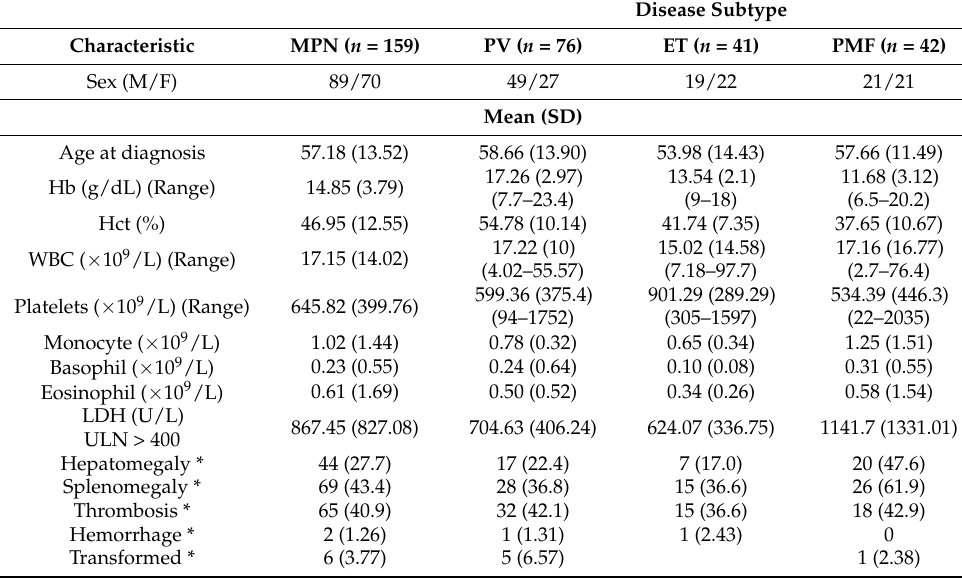
Disease Subtype